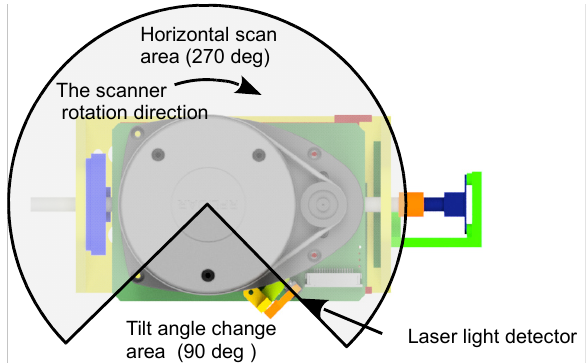
Figure 4. Schematic showing the scanning area, including scanner rotation and laser light detector placement.